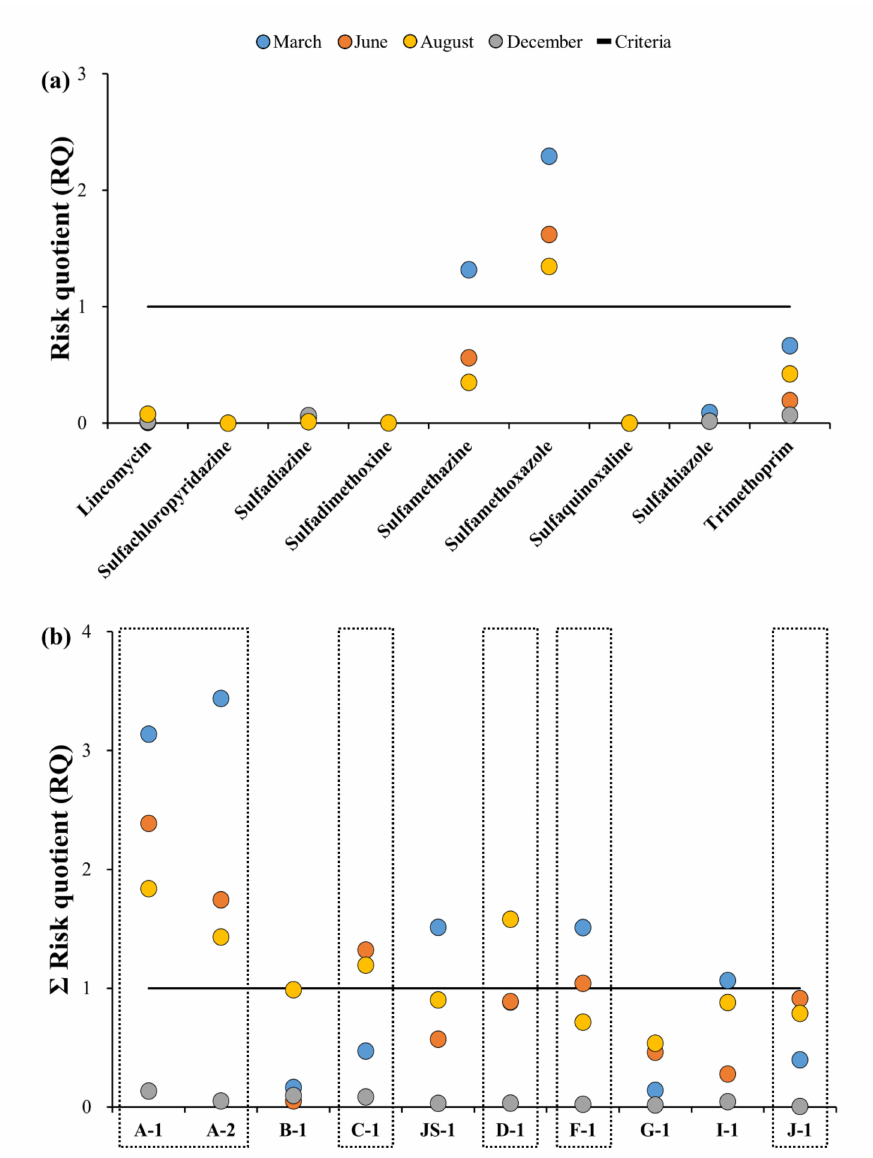
Figure 7. Ecological risk assessment of target antibiotics: ( a ) Risk quotient (RQ) for each sampling campaign and antibiotic. ( b ) RQ of each sampling campaign at each sampling point for surface water; Dotted line boxes: tributaries, Blue circle: March, Orange circle: June, Yellow: August, Grey: December, Solid line: Criteria (RQ =